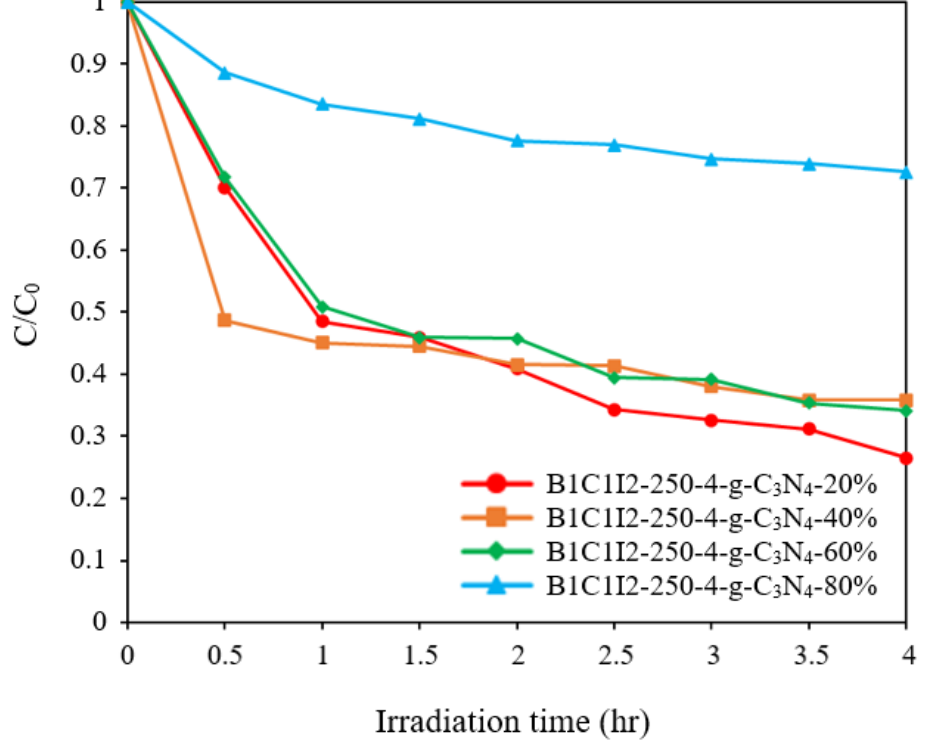
Figure 10. Photodegradation of CV with the irradiation time on BiOmCln/BiOpIq/g-C3N4 samples with g-C 3 N 4 contents of 20–80% that were prepared under a KCl:KI molar ratio of 1:2, a pH of 4, and a hydrothermal temperature of 250 °C.